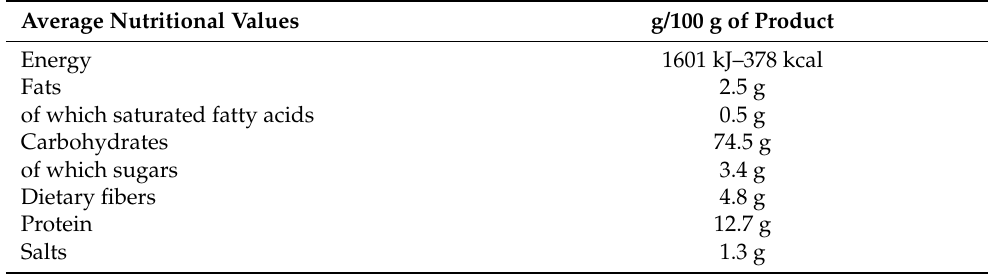
Table 1. Breadsticks nutritional